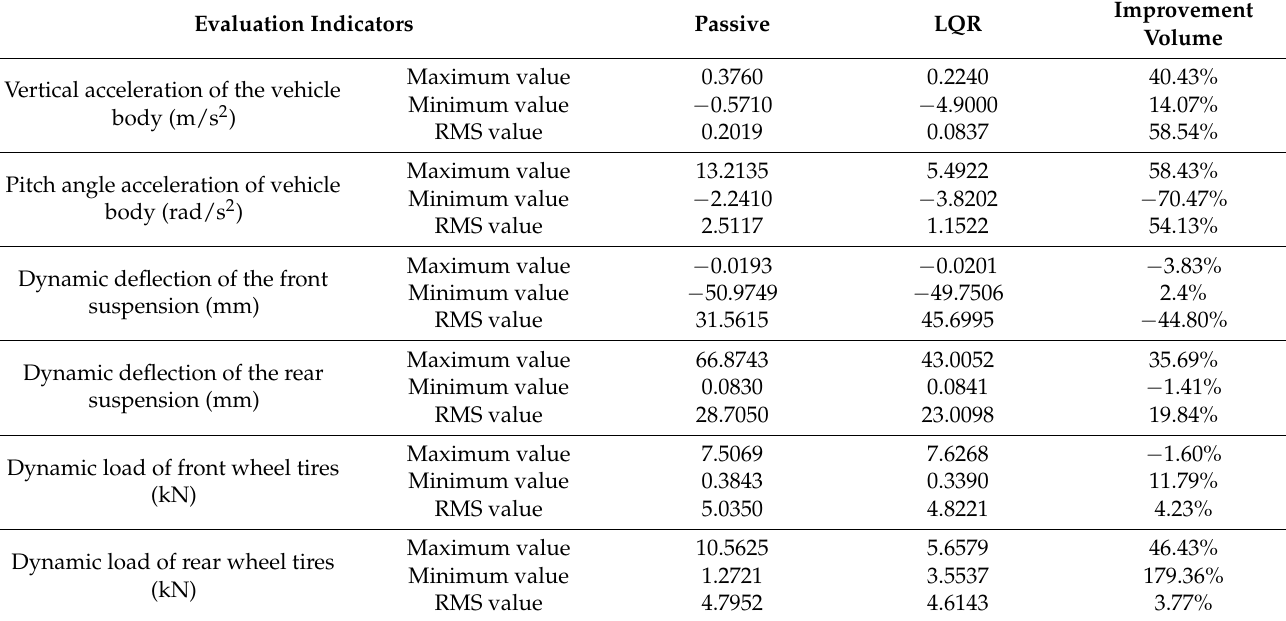
Table 10. Comparison of maximum, minimum, and RMS values for emergency acceleration simula-